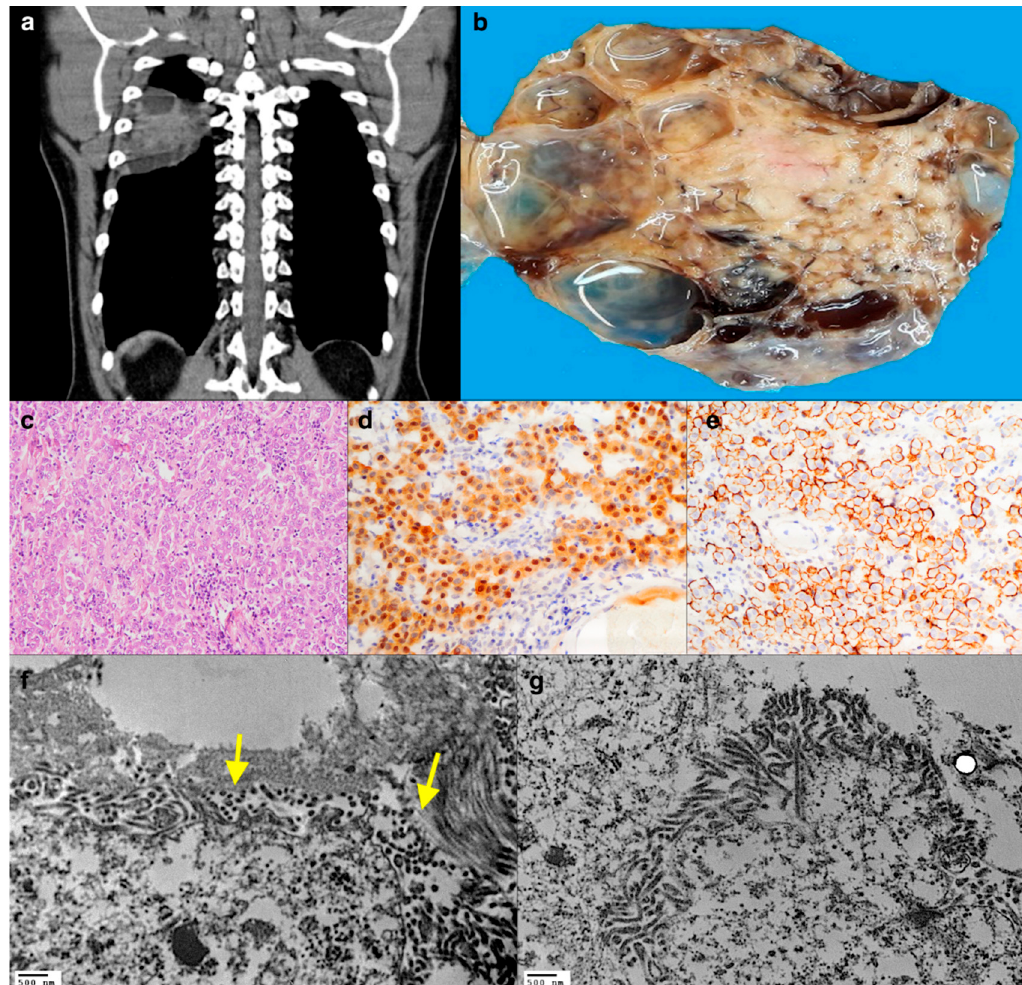
Figure 2. CT scan showing an intrathoracic mass with peripheric cystic changes ( a ), as visible at the cut surface of the gross specimen ( b ). At histology, the tumour comprised epithelioid cells with eosinophilic cytoplasm and brisk lymphocytic infiltrate ( c , haematoxylin and eosin stain, original magnification ×200) that were immunoreactive for Calretinin ( d , immunoperoxidase staining, original magnification ×200) and D2-40 ( e , immunoperoxidase staining, original magnification ×200). TEM showing the presence of numerous microvilli in direct contact with collagen bundles (yellow arrows). Although some morphological details are affected by a non-optimal conservation, the structures useful for the diagnostic definition of mesothelioma appear to be well preserved ( f , g , original magnification ×12,000, ×10,000).